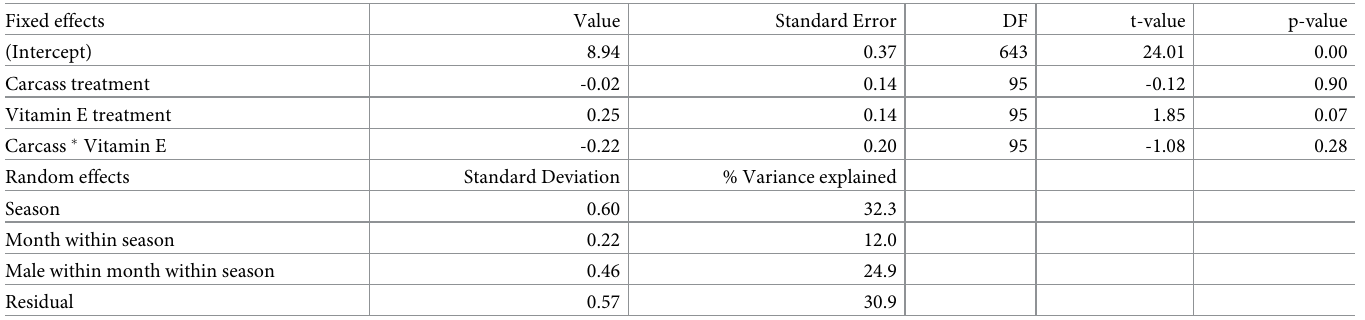
Table 2. Model parameters from the fitted linear mixed effects model for